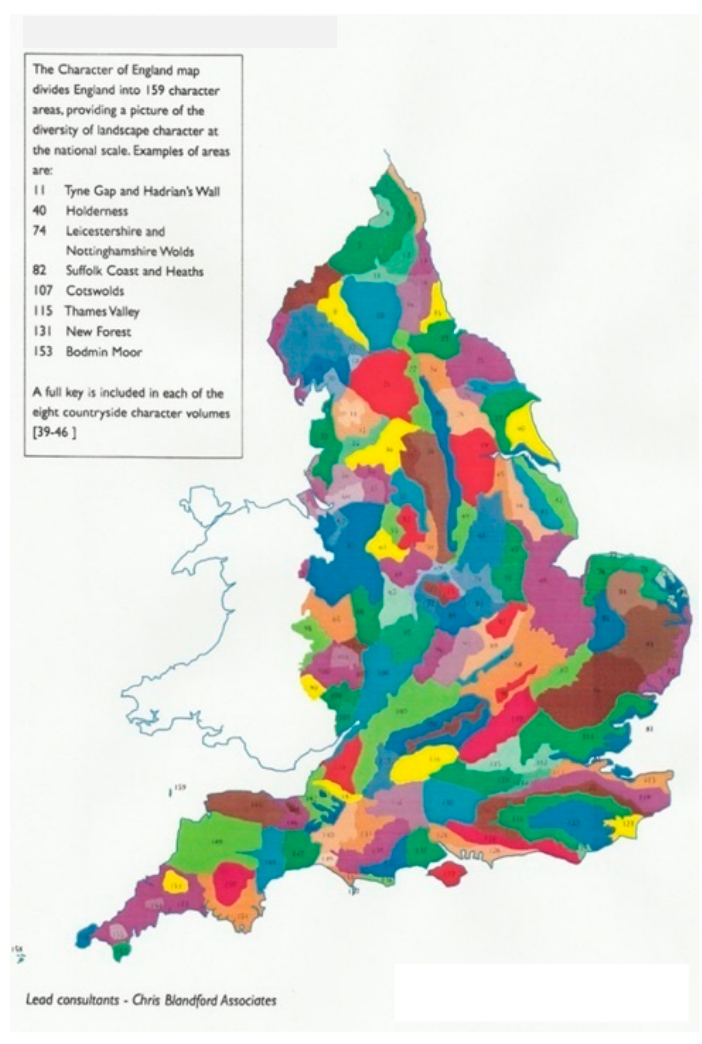
Figure 6. (Landscape) Character of England map (Countryside Agency) (Reprinted with permission of Natural England, 2022.)